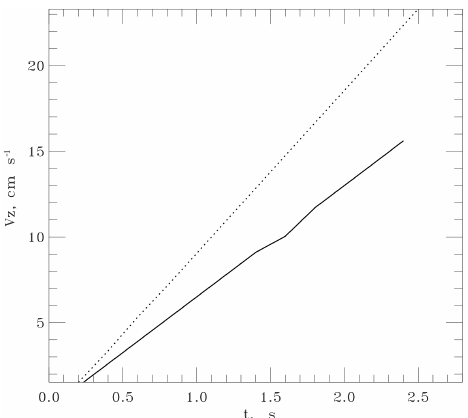
Figure 4. Amount of liquid water accumulated in particles with corresponding radius r at t = 3s (solid curve) for the cases of N tot = 55 . 5 cm − 3 (green solid curve), N tot = 555 cm − 3 (red solid curve) and N tot = 5550cm − 3 (black solid curve).